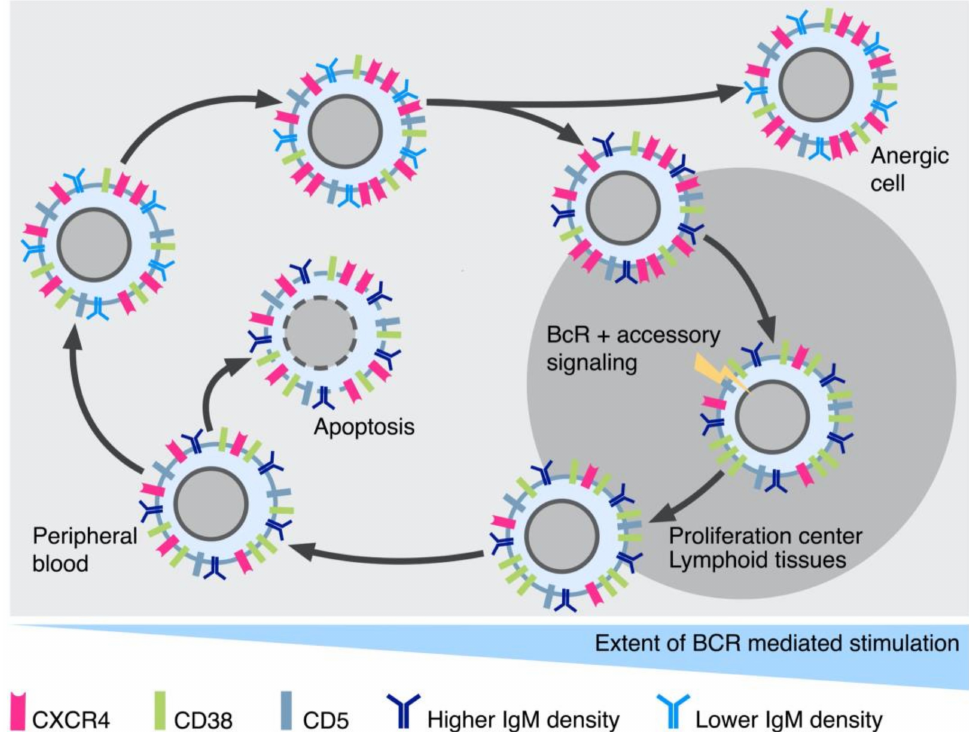
Figure 3. Hypothetical model of CLL cell turn-over. CLL cells are stimulated via BcR through the mechanisms depicted in Figures 1 and 2. The cells proliferate with the assistance of accessory cells and cytokines that are abundant in proliferating centers. Cell activation consequent to stimulation causes the downregulation of adhesion molecules, particularly of CXCR4, so that the cells can leave the proliferating centers and reach the circulation. Here, there is a progressive downregulation of ad- hesion molecules and upregulation of CD5. Concomitantly, activation molecules are downregulated, confirming the progressive tendency of CLL cells to reach a more resting state (here only CD38 is depicted among the activation molecules). A number of CLL cells undergo apoptosis outside the proliferating centers in the absence of accessory signals (this is particularly true for U-CLL cells). The CLL cells, progressively more quiescent because of the absence of stimulation, may become tolerant (particularly M-CLL cells) and/or upregulate a new set of adhesion molecules which allow re-entry into lymphoid tissues and initiate a new proliferation cycle in proliferating centers. The sIgM density varies across the different